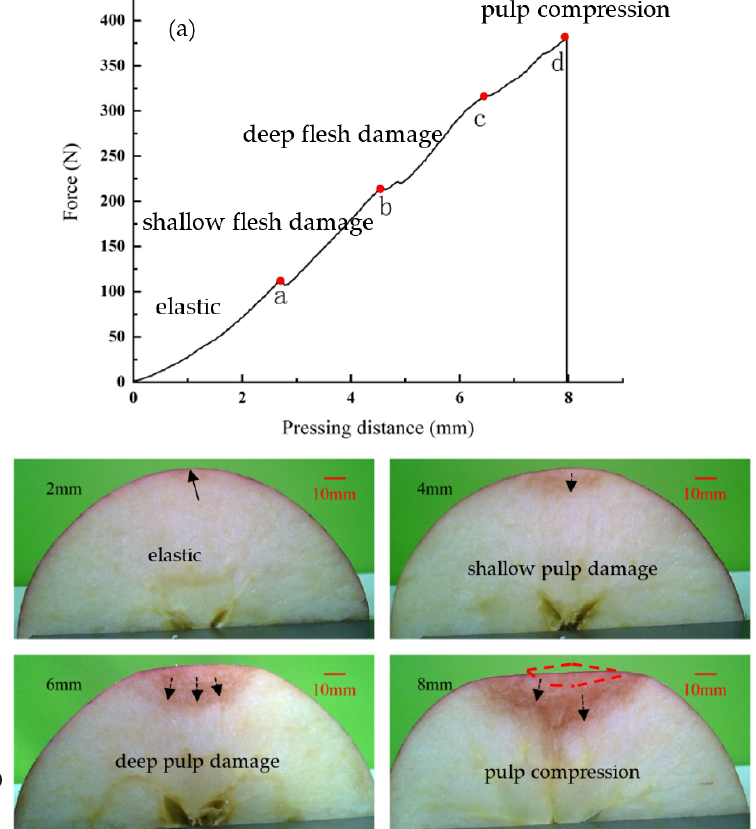
Figure 4. ( a ) Pressing distance–force curve at 8 mm distance and a speed of 2 mm/s—0–a: elasticity phase; a–b: shallow pulp damage stage; b–c: deep pulp damage stage; c–d: pulp compression stage. ( b ) Damage morphology under pressing at distances of 2, 4, 6, and 8 mm